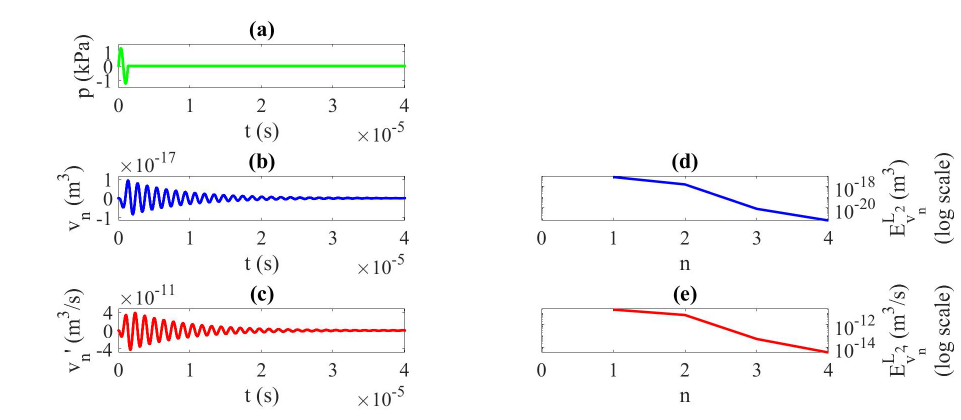
Figure 6. Case 2. f = f b , high finite amplitude with nonlinear terms. ( a ) Pressure source signal, ( b ) bubble-volume variation, ( c ) speed of bubble-volume variation; last iteration n = N . L 2 -norm error at each iteration n of the calculation; ( d ) v n , ( e ) v (cid:48) n